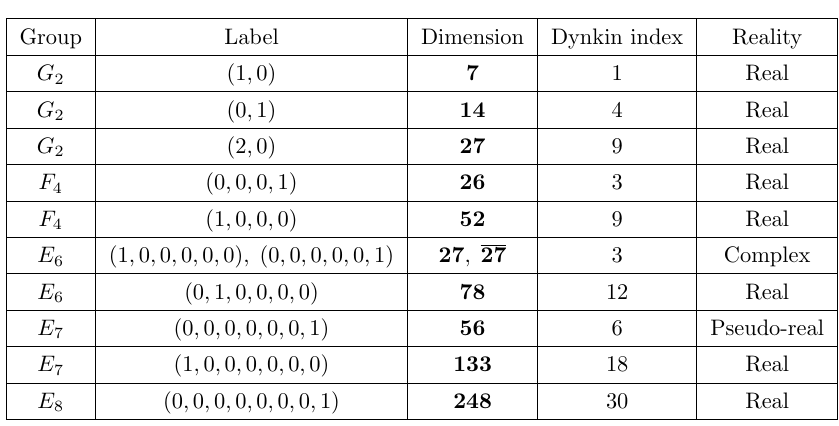
Table 23 . Various group theory data for representations of the exceptional groups. Here the group entry stands for the group in question, and the label entry stands for the standard Dynkin label of the representation. Additionally, the dimension, Dynkin index and the reality properties of the representation are